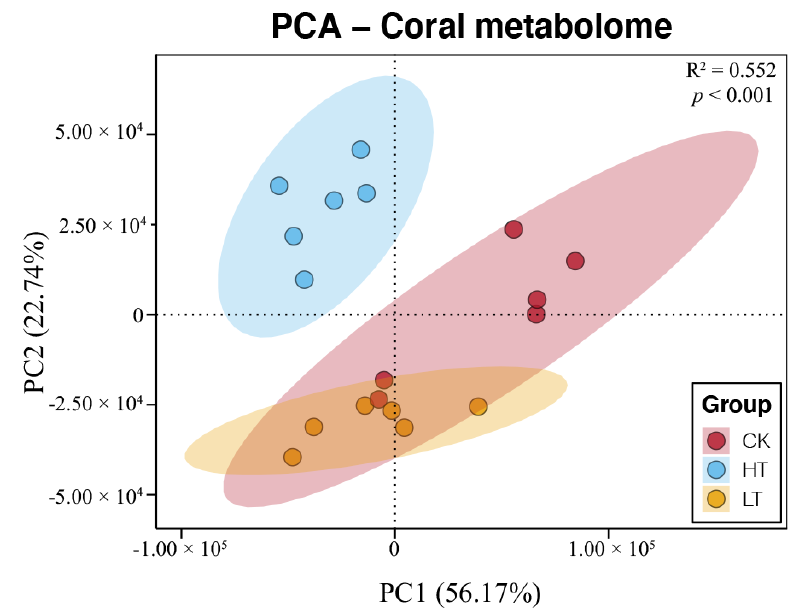
Figure 4. PCA and PERMANOVA of the metabolome of corals under different temperature